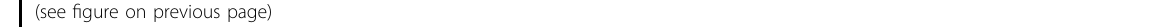
Fig. 2 Early activation and block of autophagy in laminopathic white preadipocytes. a Control and FPLD2 cultured preadipocytes from subcutaneous tissue were costained for lamin A/C (green) and emerin (red) or prelamin A (green) and PPAR γ (red). Bar, 10 μ m. b Quantitative RT-PCR analysis of mRNA levels of WAT markers ADIPOq, GLUT4, and leptin in control or FPLD2 white preadipocytes, either non-differentiated (ND) or after 9 days of differentiation in WAT medium (WAT). Statistically signi fi cant differences between values measured in control and the corresponding ND or WAT FPLD2 cells are indicated (*). A signi fi cant decrease in leptin values in WAT FPLD2 vs. ND FPLD2 is also indicated (*). c Control cultured preadipocytes left untreated (sAT) or treated with AFCMe (A-sAT) were examined for autophagic markers. Western blotting analysis of prelamin A, P62, and LC3 (LC3I and LC3II forms) in sAT and A-sAT cells under basal conditions (ND) or differentiated in WAT medium for 9 days (WAT). GAPDH bands are shown as protein-loading controls. Molecular weight markers are reported in kDa. Densitometric analysis of immunoblotted prelamin A, P62, and LC3II bands is reported in the graphs. Statistically signi fi cant differences between values measured in untreated and the corresponding chloroquine-treated cells are indicated (*). d Immuno fl uorescence detection of P62 (green) and LC3 (red) in sAT and A-sAT cells under basal conditions (ND) or differentiated in WAT medium for 9 days (WAT). DNA was stained with DAPI (blue). Statistical analysis of the number of P62 and LC3 puncta is reported in the graphs. Statistically signi fi cant differences between values measured in sAT and the corresponding A-sAT cells are indicated (*). Bar, 10 μ m. e GFP-LC3II and FLAG-LA staining in control WAT adipocytes expressing wild-type LMNA or R482Q- LMNA . Statistical analysis of the number of cells with GFP-LC3II puncta is reported in the graph. Fifty cells showing FLAG staining of the nuclear lamina were examined per sample. Statistically signi fi cant differences between values measured in wild-type LMNA and the corresponding R482- LMNA cells are indicated (*). f Electron microscopy analysis of sAT and A-sAT cells under basal conditions (ND) or after 9 days in WAT medium (WAT). Arrowheads: autophagosomes; arrows: autolysosomes. Bar, 1 μ m. The percentage of cells with more than three autophagosomes/autolysosomes is reported in the graph. Fifty cells per sample were counted in three independent experiments. Three biological replicates were used in each experiment as well as in qRT-PCR analyses. Statistically signi fi cant differences between values measured in sAT and the corresponding A-sAT cells are indicated